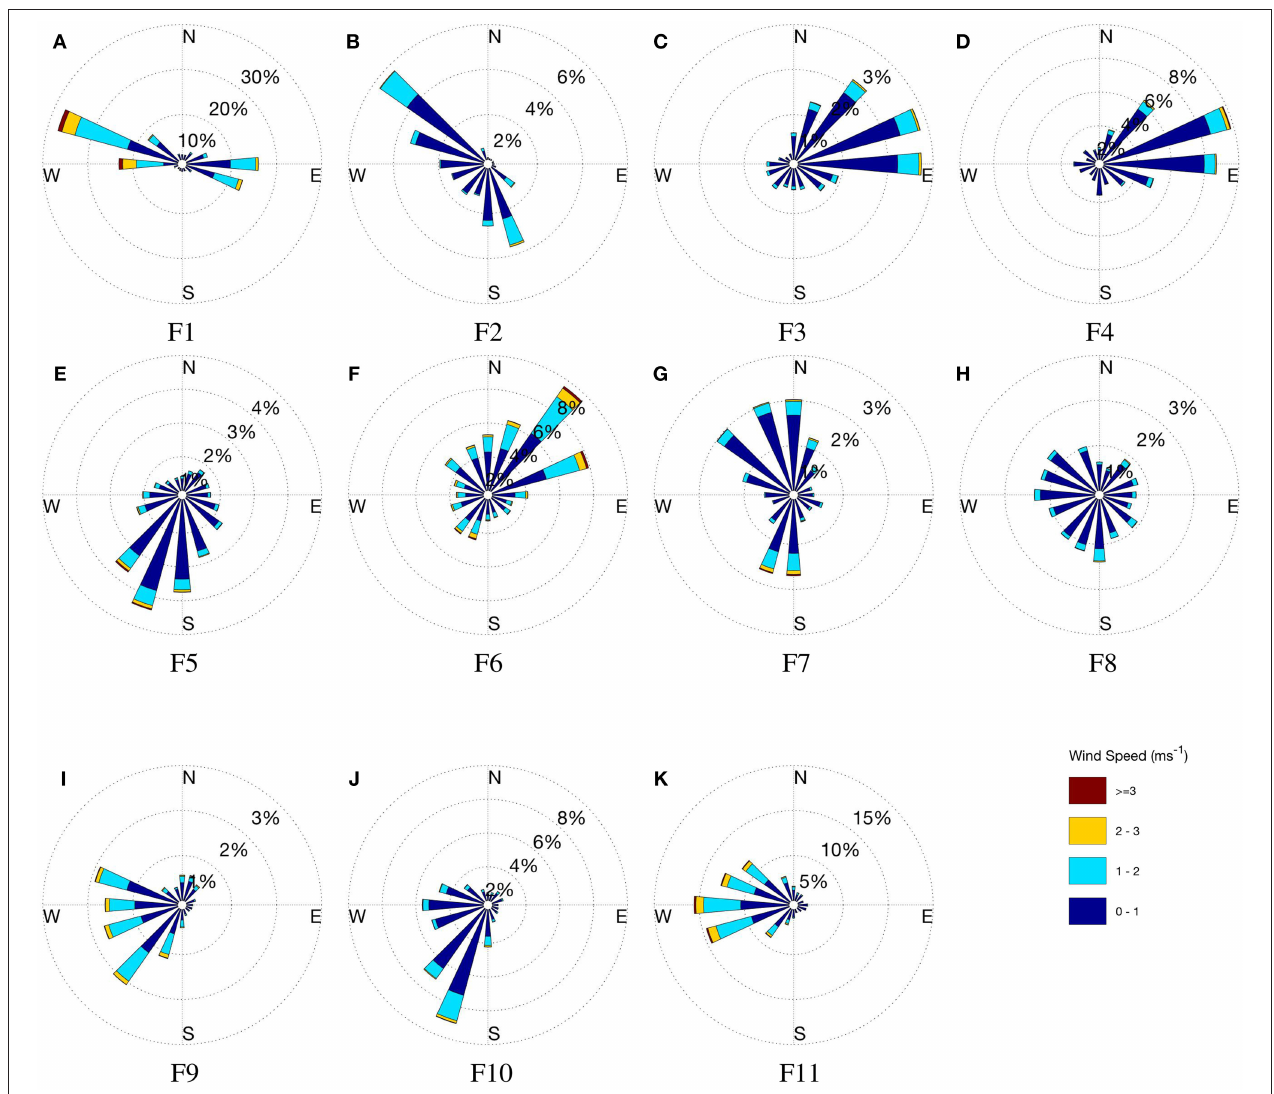
FIGURE 2 | Observed wind roses for each site (A–K) F1 to F11, across Flea Creek